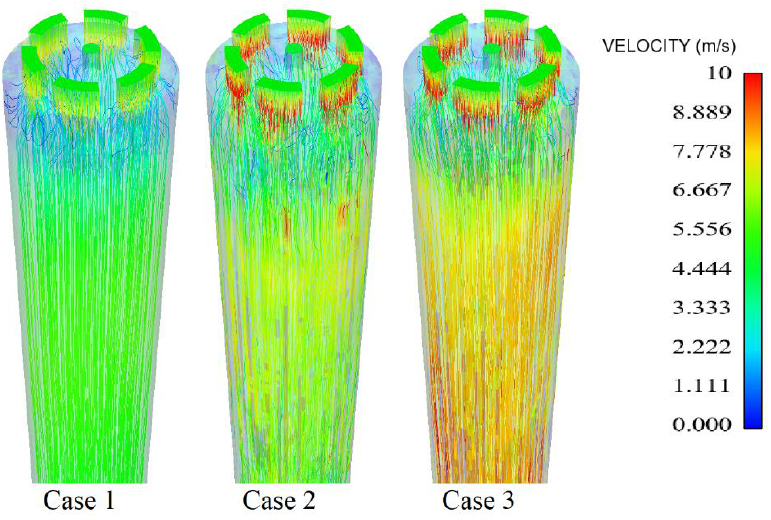
Figure 11. Velocity profile for selected